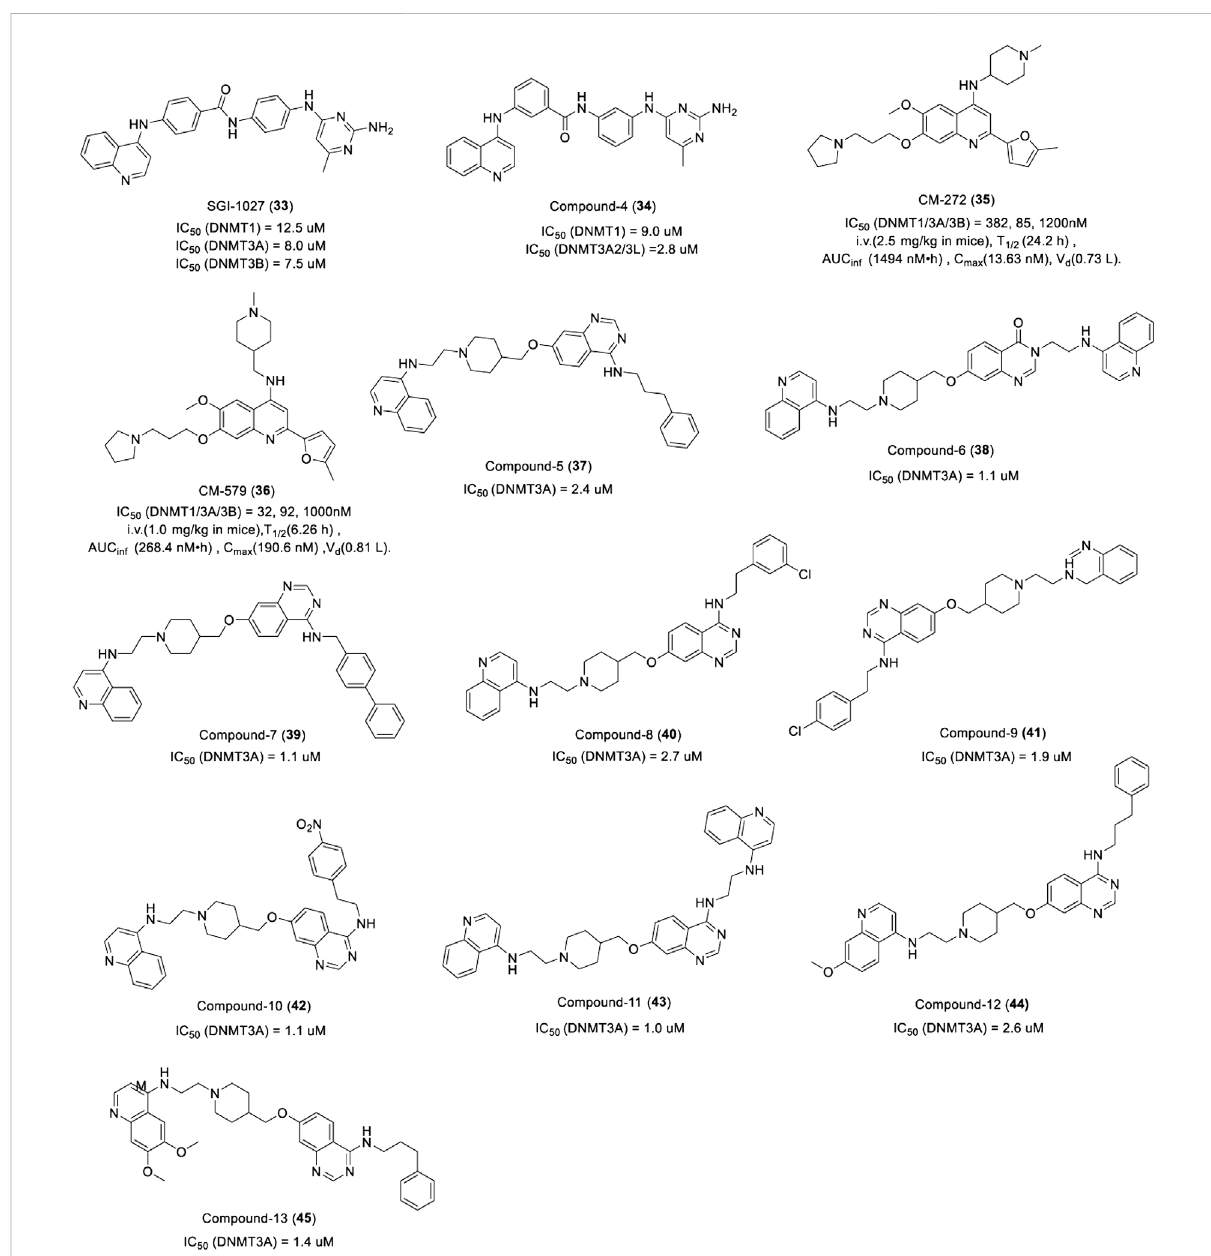
FIGURE 8 Chemical structure of quinolone- and quinazoline-based DNMTis in pre-clinical.